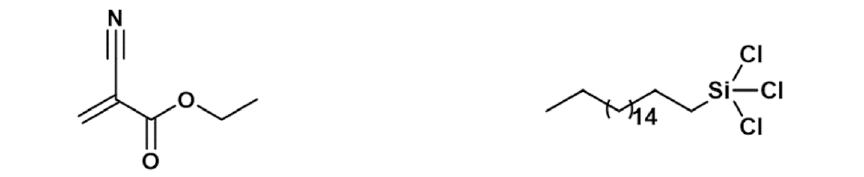
Figure 2. Structure of hydrophobic agents.